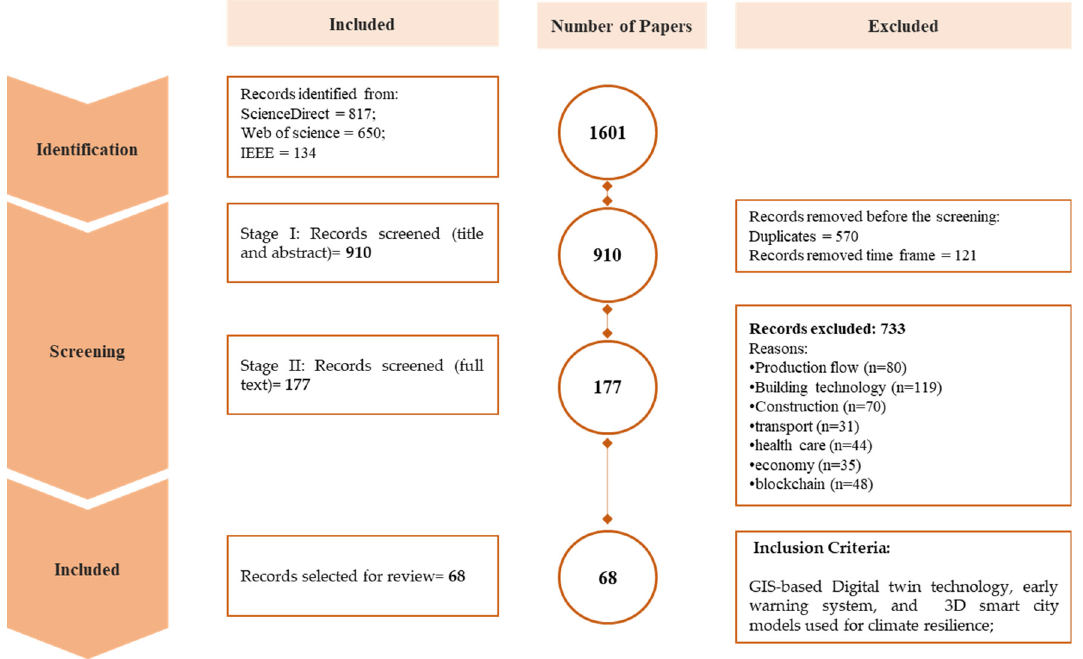
Figure 4. Schematic representation for the selection of literature reviewed based on the PRISMA approach. Table 1. List of search queries conducted in this study.